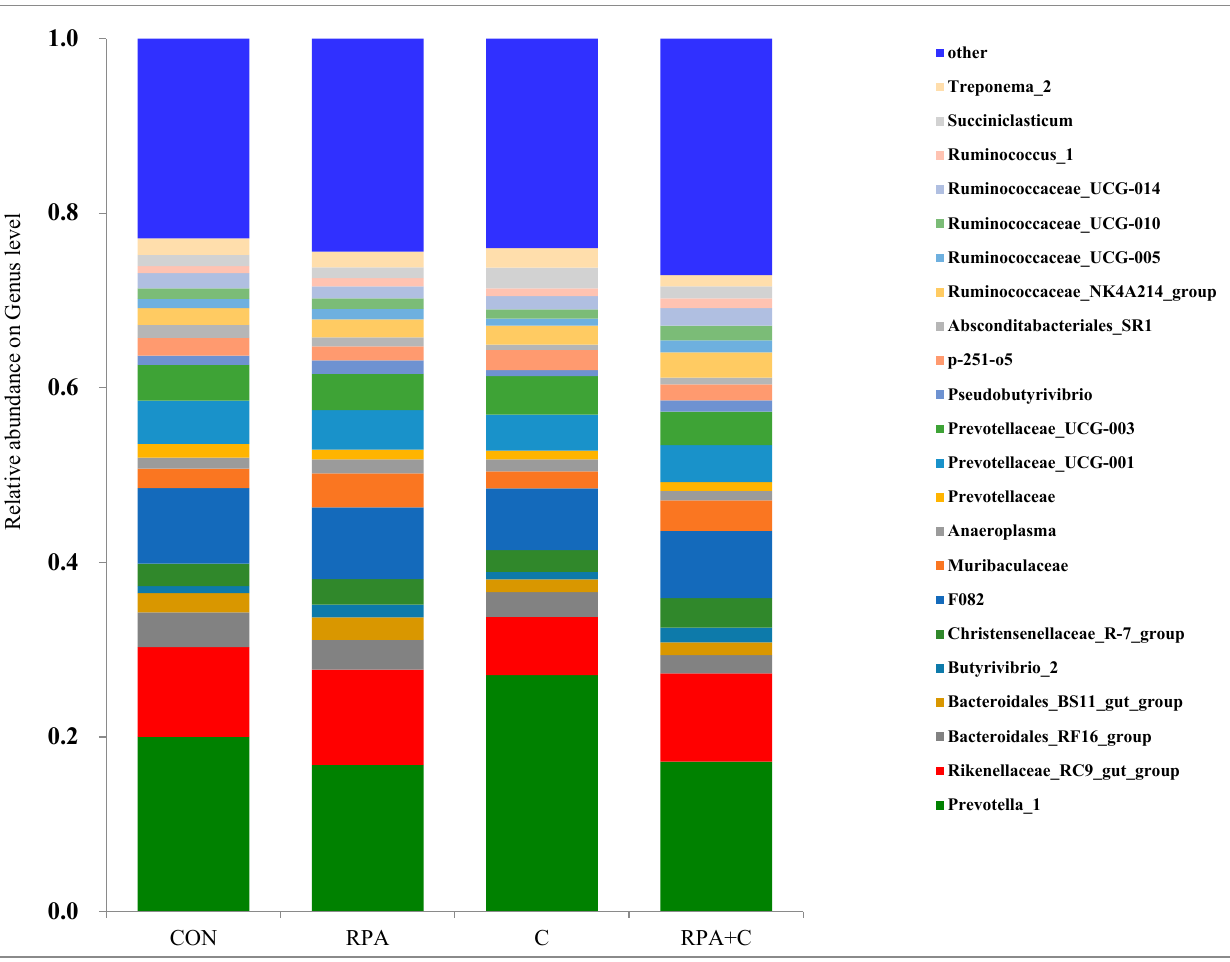
Figure 4. Genus-level average relative abundances (percentage of total reads) of the rumen microbial communities of grazing, lactating yaks offered supplementary 15 g/day RP-Lys and 5 g/day RP-Met (RPA), 1.2 kg/day concentrate (C) and 15 g/day RP-Lys, 5 g/day RP-Met and 1.2 kg/day concentrate (RPA+C), or no supplements (control-CON). Table 4. Relative abundances (percentage of total reads) of rumen bacteria at genus level in grazing, lactating yaks offered supplementary